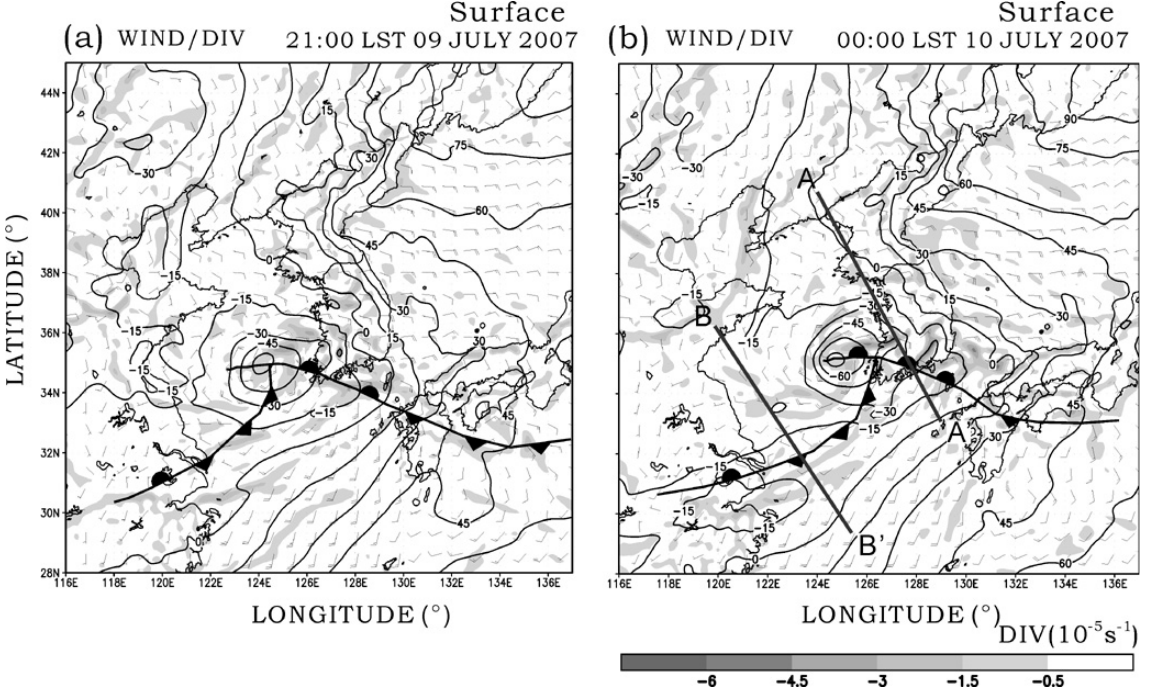
Fig. 4. Mesoscale analysis of divergence (10 − 5 s − 1 , shaded), geopotential height (contoured every 5gpm), and horizontal wind (ms − 1 , barbs at surface for (a) 21:00LST, 9 July and (b) 00:00LST, 10 July 2007. For winds, full (half) barbs denote 5ms − 1 (2.5ms − 1 ) . The location of the front at each time is superimposed. The lines A–A 0 and B–B 0 are used to construct Figs. 5 and 6.